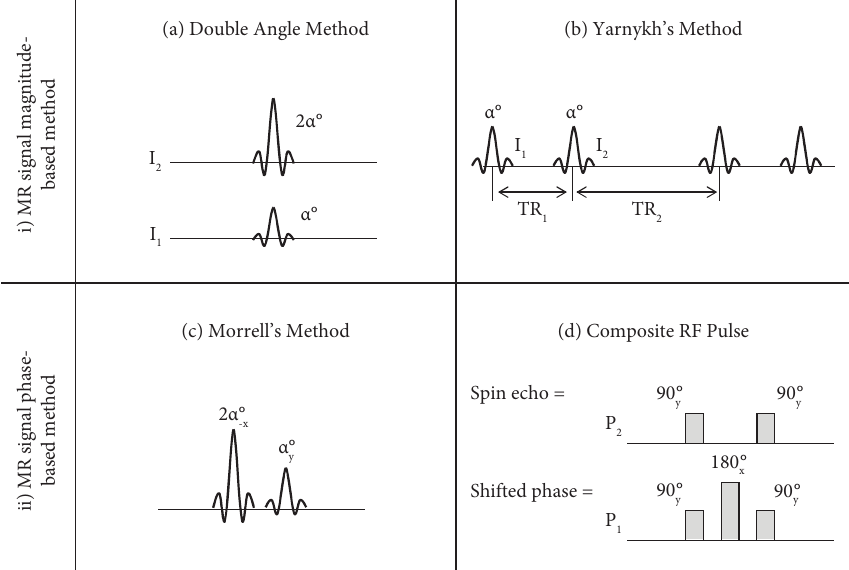
Figure 2: Computational simulation studies to evaluate the proposed B 1 mapping method using a composite RF pulse (d) and other B 1 mapping methods, such as the double angle method (a), Yarnykh’s method (b), and Morrell’s method